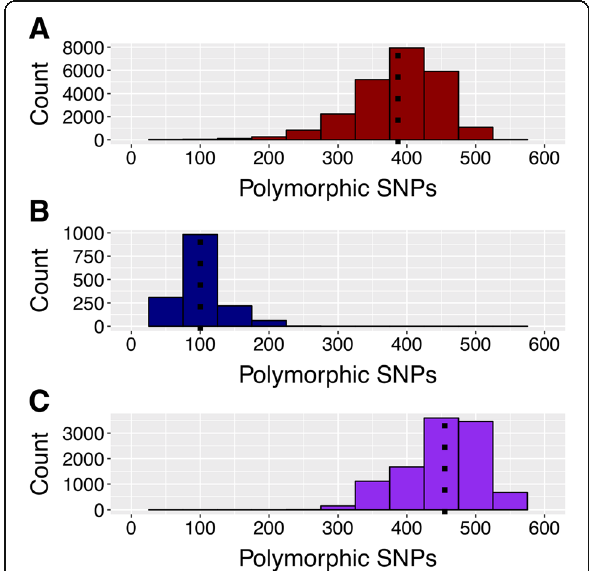
Fig. 4 Polymorphic SNPs distribution across pairwise combinations of a ) indica x indica , japonica x japonica b ), and c ) indica x japonica. Distribution of polymorphic markers between pairs of accessions from a ) indica